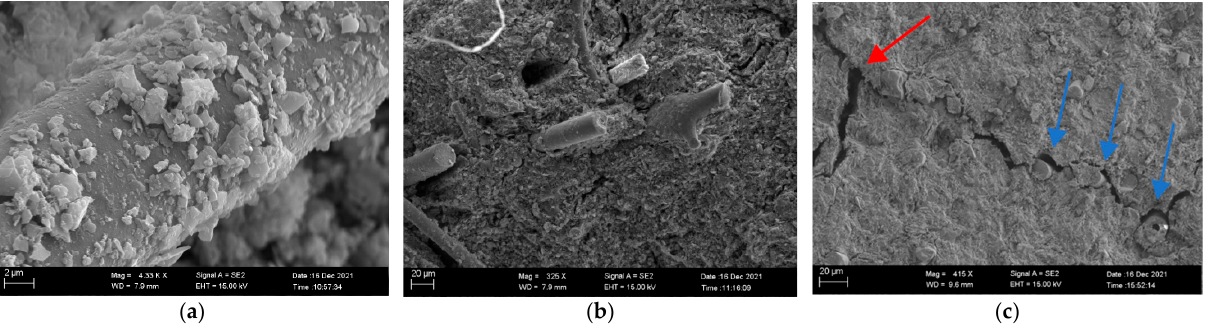
Figure 4. SEM photos of the interface between mullite fiber and geopolymer matrix: ( a ) geopolymer grains on mullite fibers, ( b ) fiber pullout, ( c ) crack deflection.